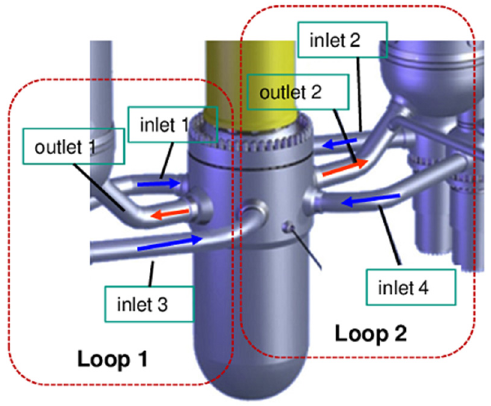
Figure 2. The diagram of the primary circuit of AP1000.